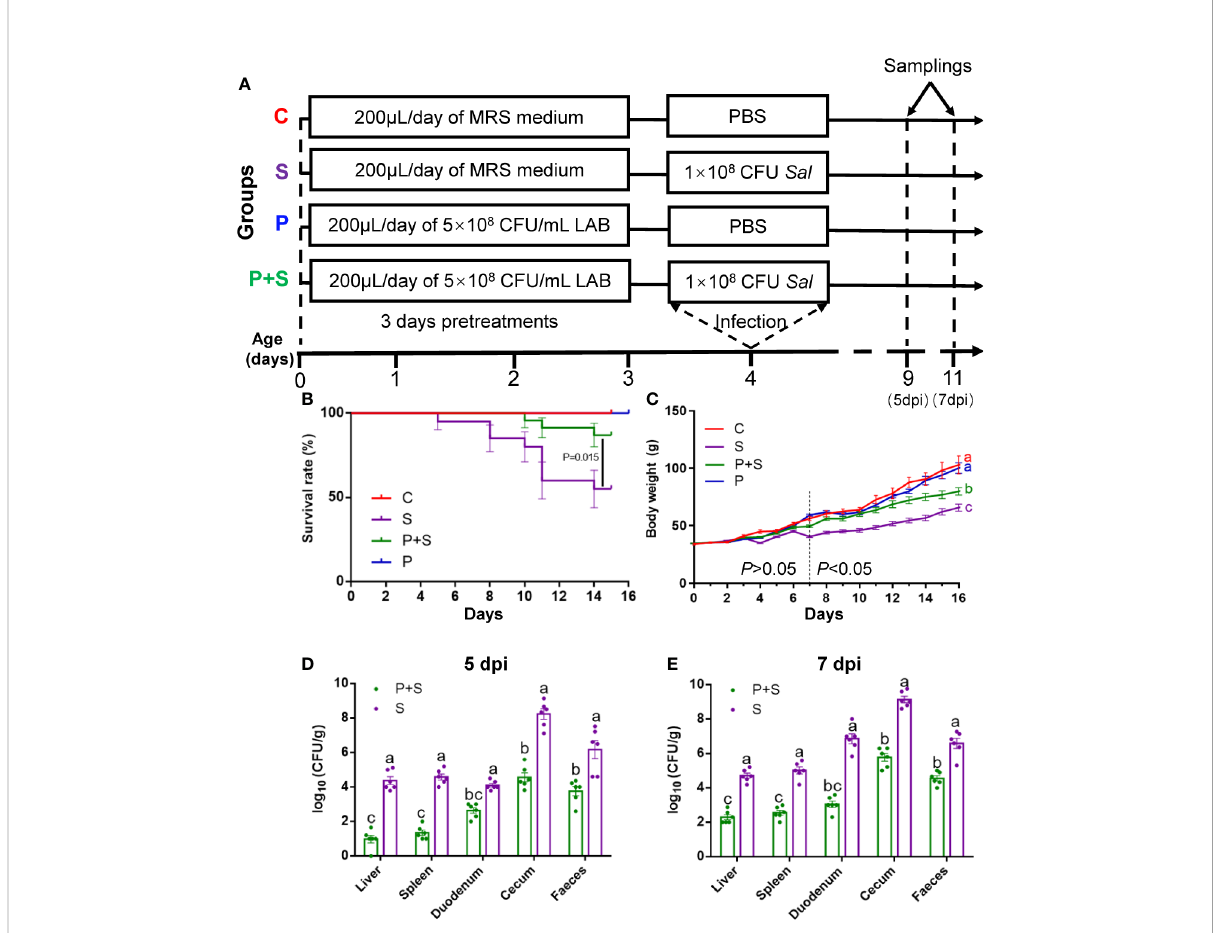
FIGURE 1 Study design and protective effect of LAB against Salmonella fatal infections. At the beginning of three days of age, chicks in groups P and P+S received 0.2ml phosphate-buffered saline (PBS) containing 1×10 8 CFU of the L. rhamnosus P118. On the fourth morning, groups S and P+S received 1×10 8 CFU of the S. Typhimurium SL1344, via oral gavage. The chicks in the C group received 0.2ml of sterile PBS (A) , chick survival rate (B) , chick growth status (C) and determination of bacterial load in tissues and organs infected with Salmonella on 5-day (D) and 7-day- post-infection (dpi) (E) . a, b, c, d: indicated the same column with different letters differ signi fi cantly ( P <